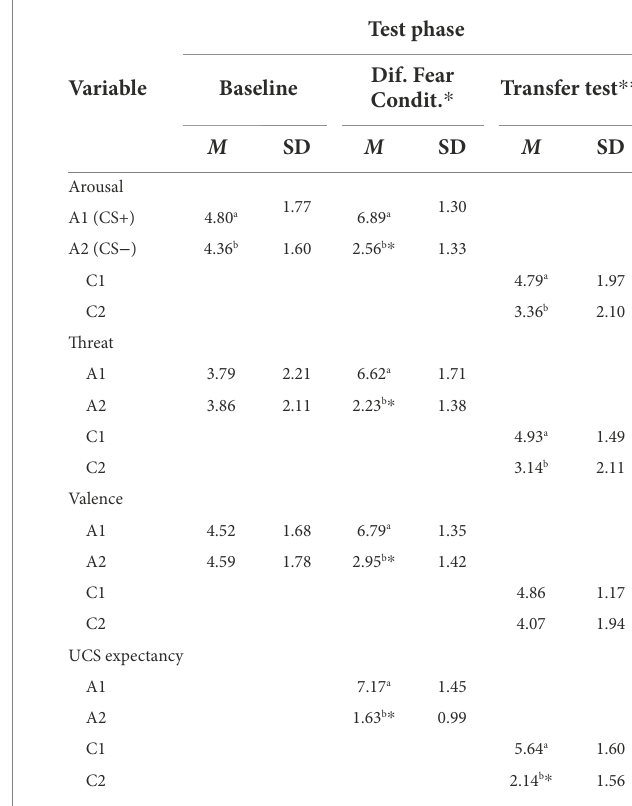
TABLE 1 Average evaluative ratings and UCS expectancy to A1, A2, C1, and C2, after Baseline, Differential Fear Conditioning, and Transfer Test